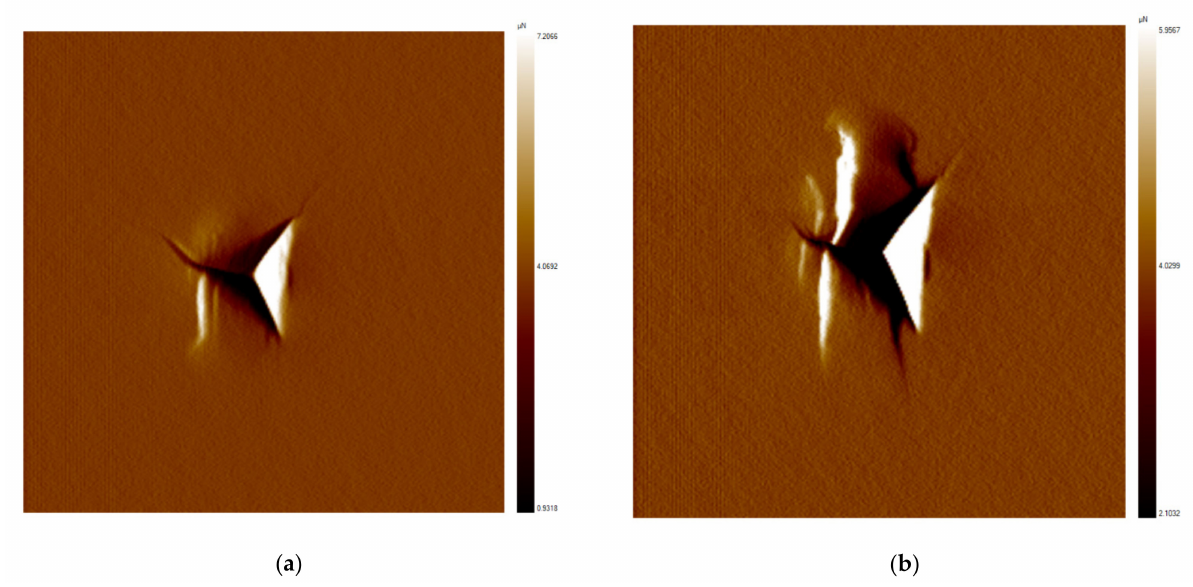
Figure 10. LN surface fracture under high load. ( a ) 20 mN; ( b ) 30